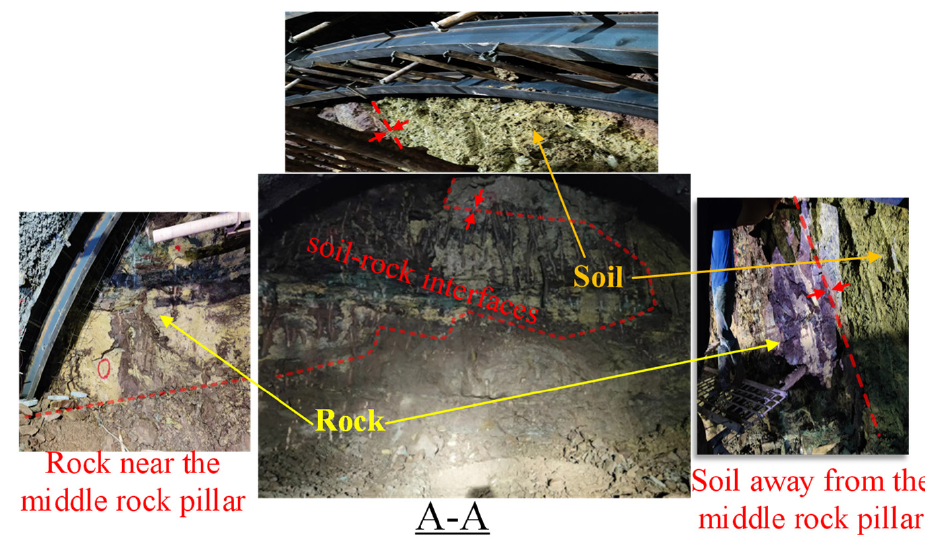
Figure 2. Longitudinal view of the soil-rock interface at the tunnel entrance.